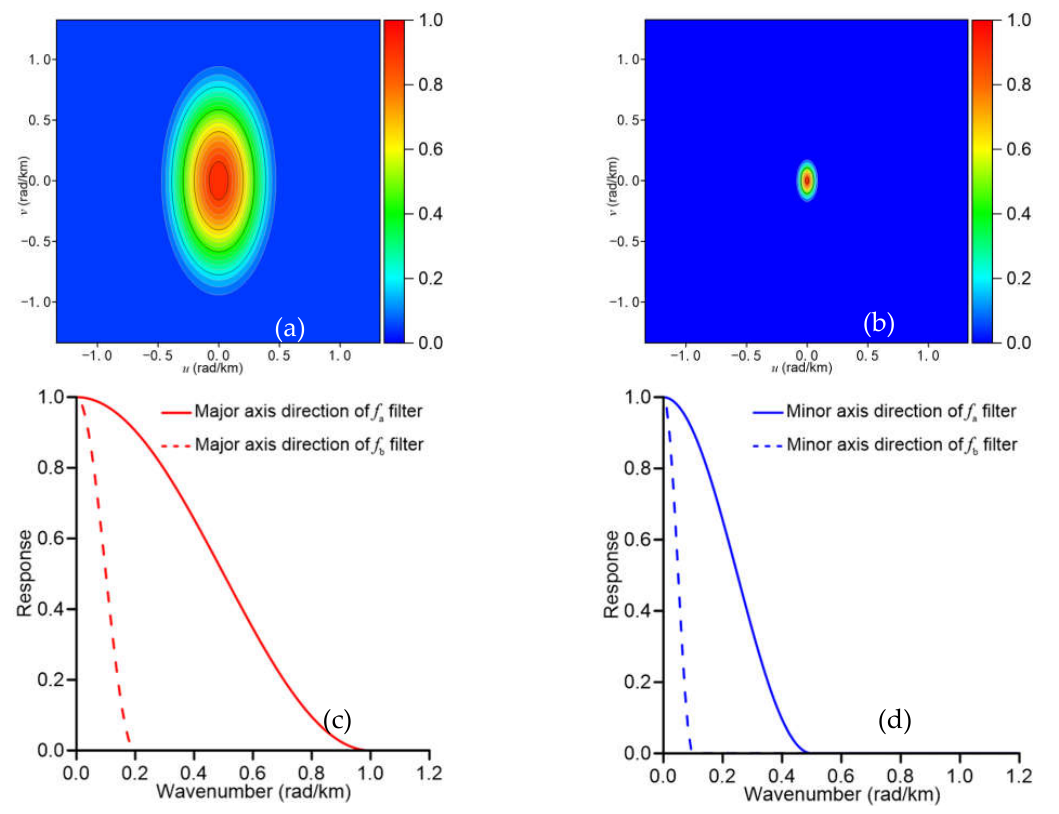
Figure 3. The responses of the f a and f b filters. ( a ) The response of the f a filter. ( b ) The response of the f b filter. ( c ) The response of the f a and f b filters in the direction of the major axis. The solid red line and the dashed red line denote the response of the f a and f b filters in the direction of the major axis, respectively. ( d ) The response of the f a and f b filters in the direction of the minor axis. The solid blue line and the dashed blue line denote the response of the f a and f b filters in the direction of the minor axis, respectively.